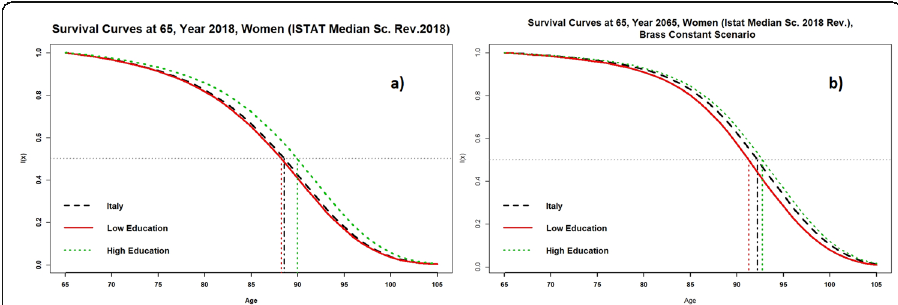
Fig. 4 Survival curves at age 65 for women, low vs high education level and the whole female Italian population. a Year 2018. b Year 2065. Source: ISTAT official forecasts (Median Scenario, 2018 Revision) and our own projections (Brass